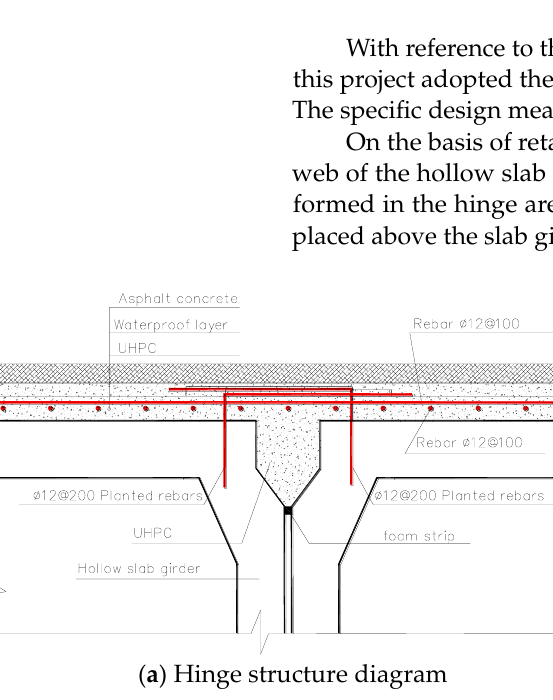
Figure 5. Hinge and pavement reinforcement structure.